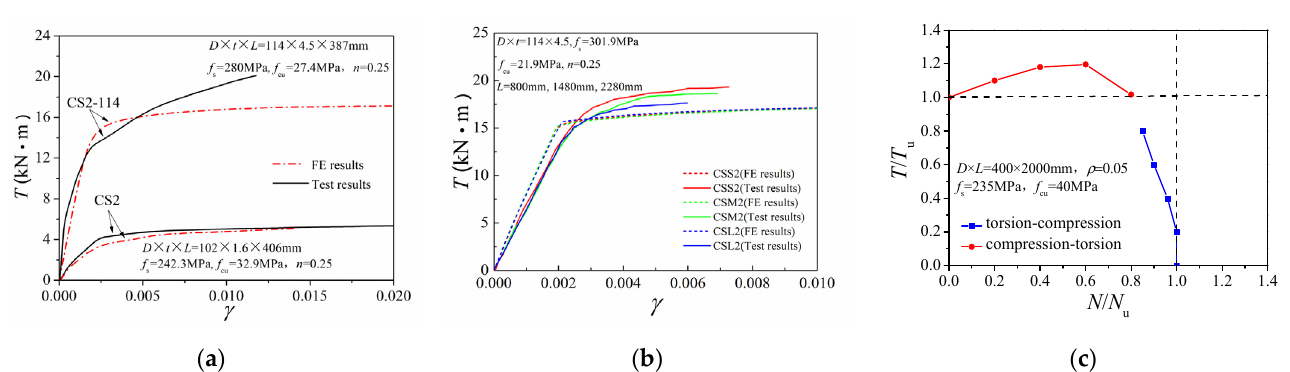
Figure 2. Comparison between the T – γ curve results of the FE model and the test: ( a ) CS2 and CS2-114; ( b ) CSS2, CSM2 and CSL2; ( c ) C2-1.